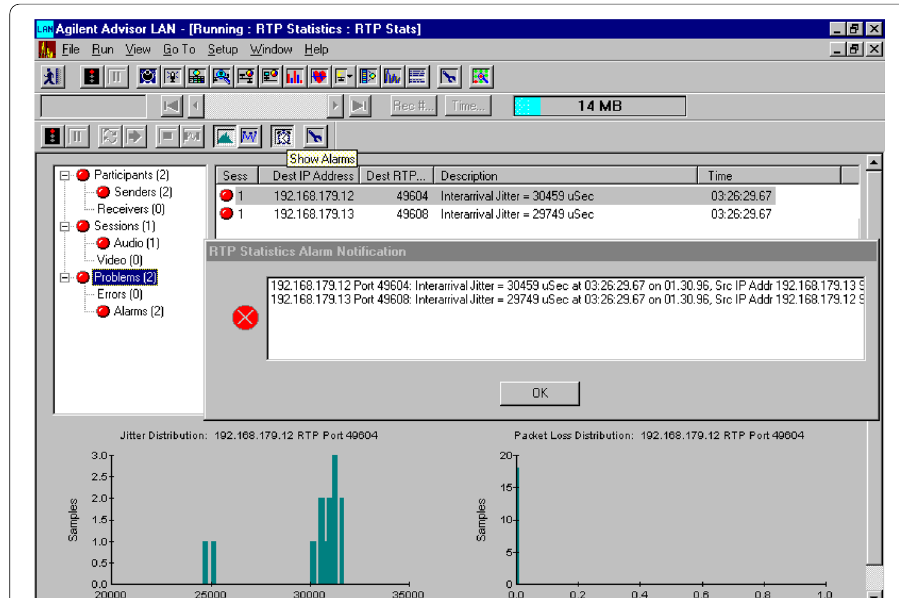
Fig. 13 Histogram of RTP packets jitter and loss